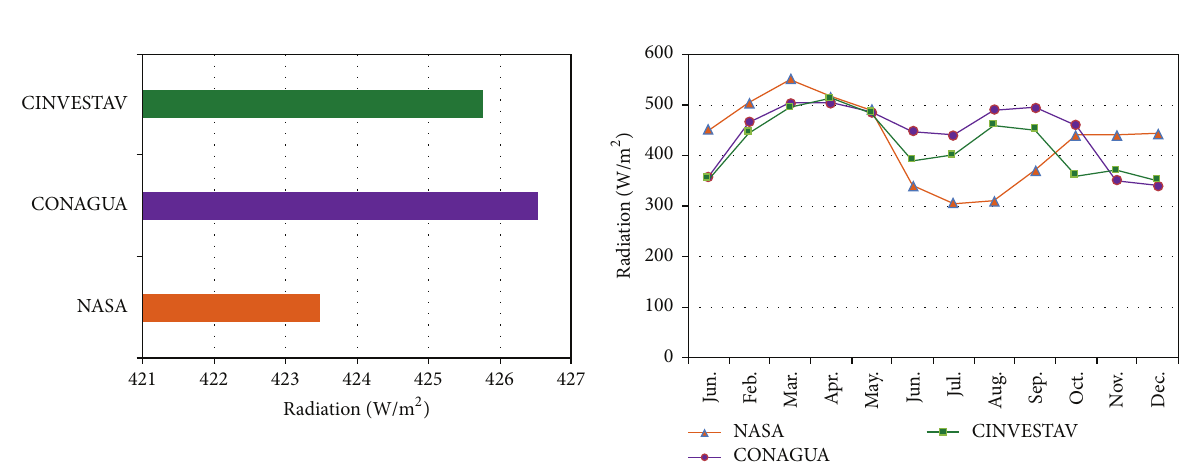
Figure 3: Radiation annual and monthly daily